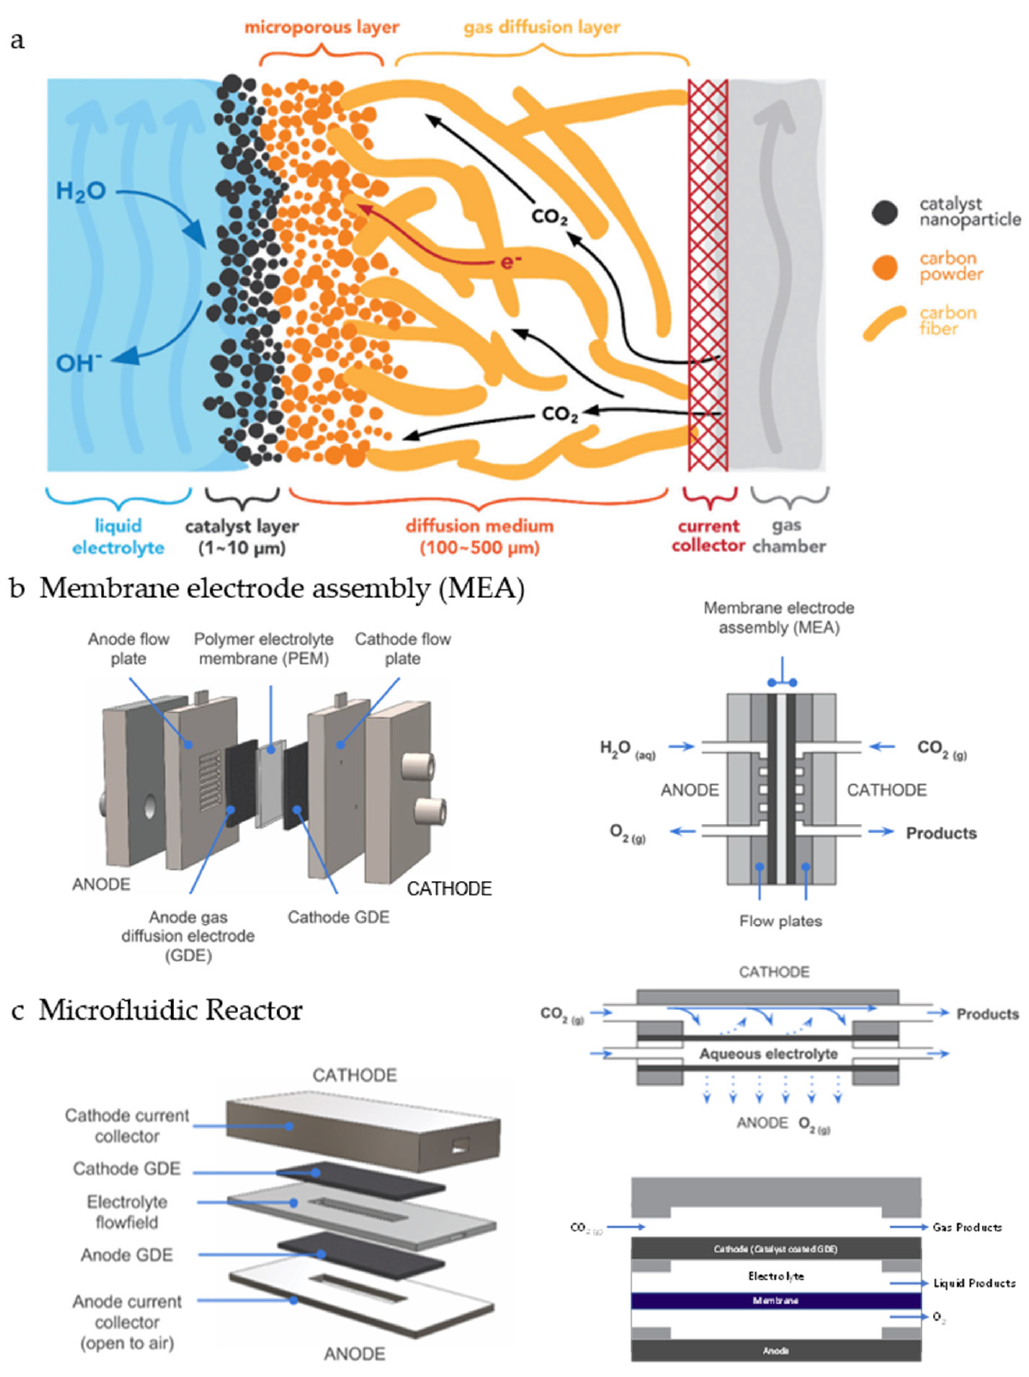
Figure 10. ( a ) Schematic of a gas di ff usion electrode (GDE). [87] Copyright 2018, Royal Society of Chemistry. ( b , c ) Exploded (left) and cross-sectional (right) diagrams of two common flow cells for CO 2 RRs. ( b ) Membrane-based reactor containing a membrane electrode assembly (MEA) consisting of anode and cathode GDEs and ( c ) a microfluidic reactor with (top) and without (bottom) a membrane consisting of a liquid electrolyte flow channel for the anode and cathode GDE materials while CO 2(g) is supplied to the cathode side of the cell, where it di ff uses to the electrocatalyst through the gas di ff usion layer (GDL). [85,88] Copyright 2018, ACS. Copyright 2019,